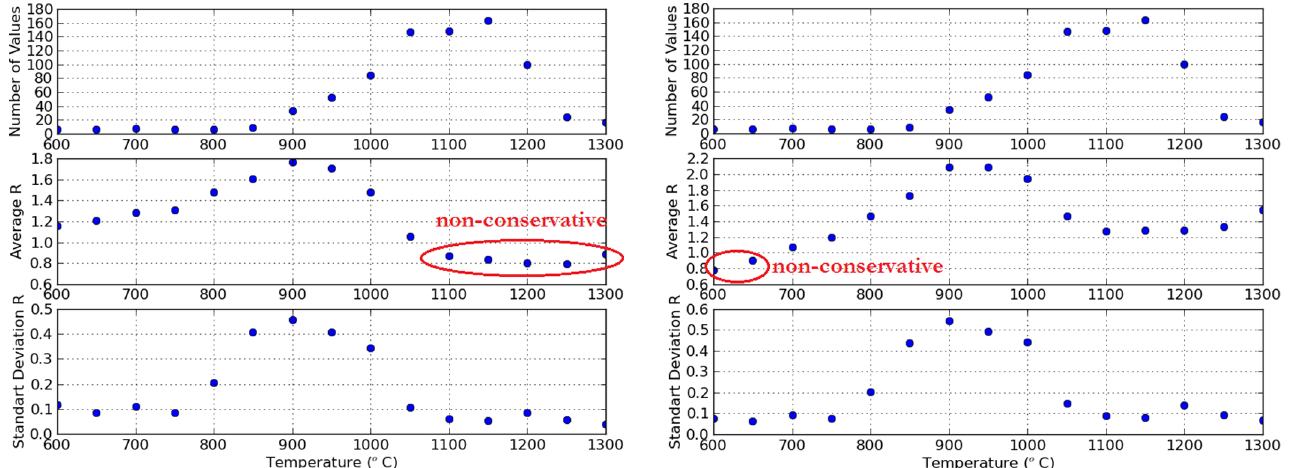
Fig. 10. Comparison of experimental and correlation data. R -parameter for each evaluated temperatures, Yegorova (left), Baker-Just